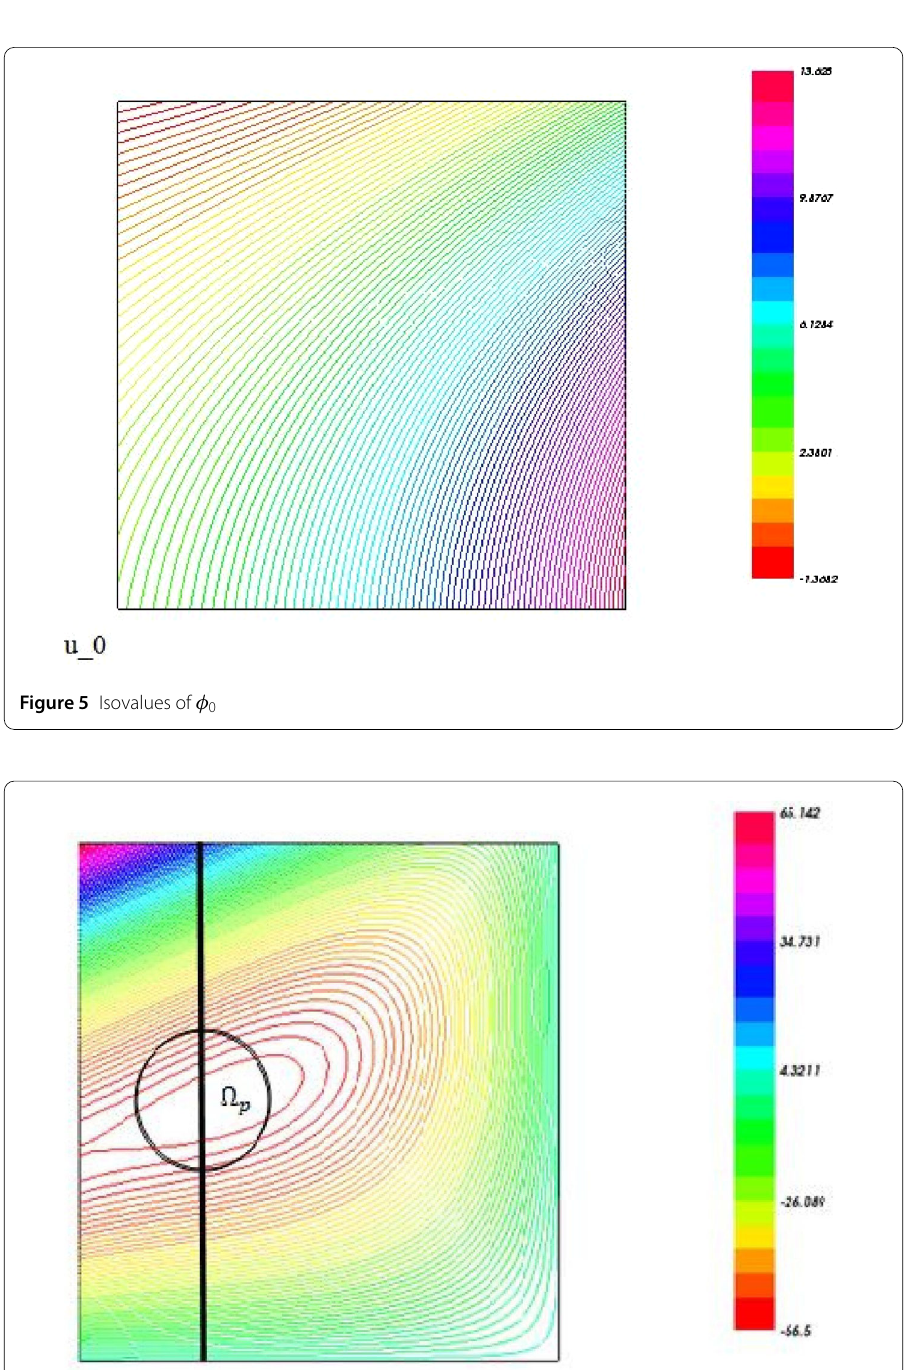
Figure 6 Isovalues of the topological gradient δ T